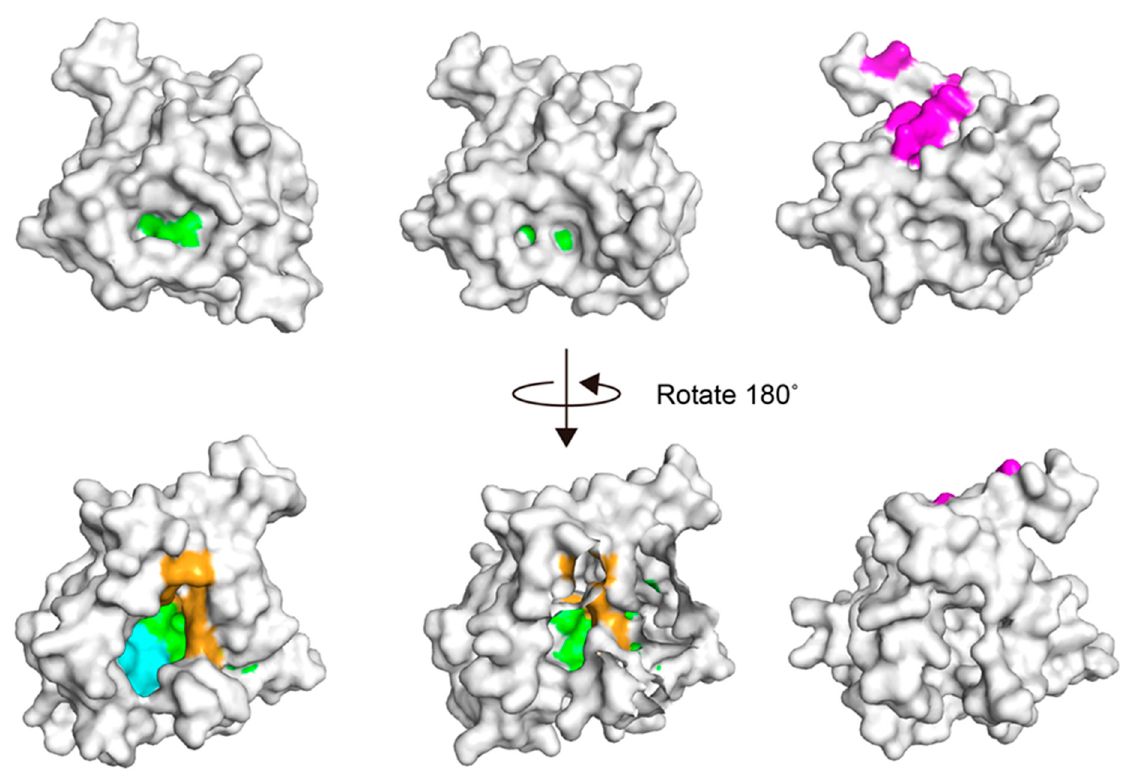
Figure 7. Crystal structures of F1*S ( left ) and A ( middle ) variant hAGPs and a built model structure of cAGP ( right ). The A variant of cAGP was only showed one of subunits. The highlighted residues in the Figure 6 were colored in the structures.